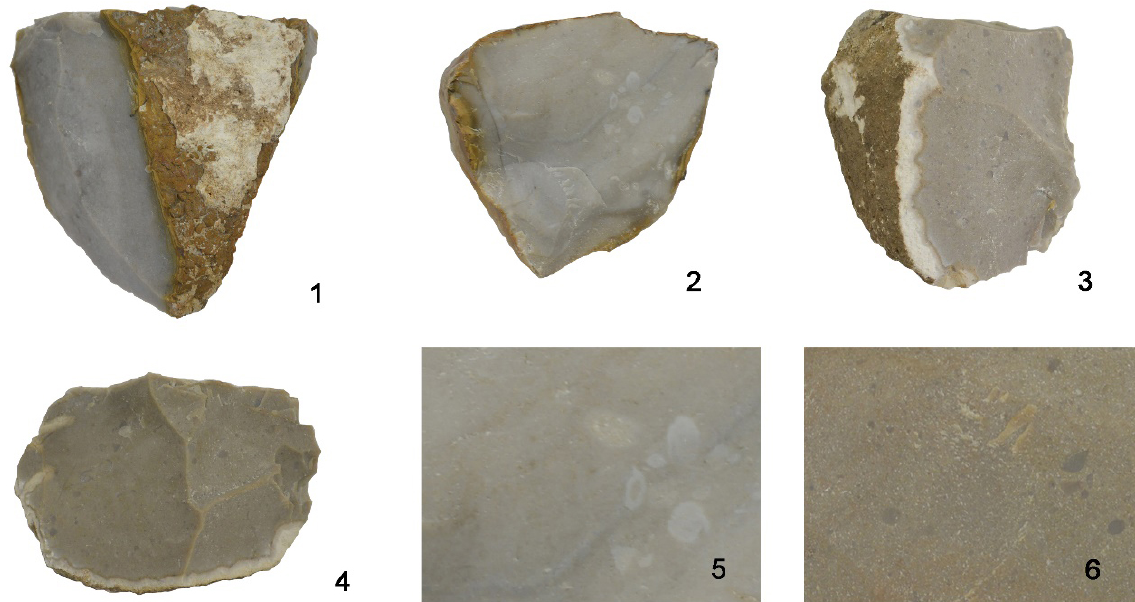
Figure 5. Flint preforms used for experiments conducted with an electrical furnace. 1, 2: Made of river cobble flint. 3, 4: Made of nodule flint. 5: Close-up view of river cobble flint. 6: Close-up view of nodule